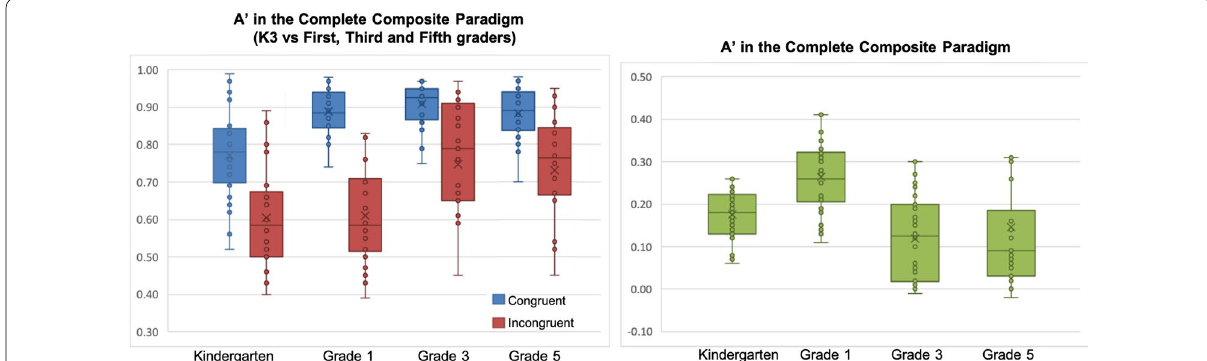
Fig. 4 A ′ of congruent and incongruent trials in the holistic processing task (left) and Holistic A ′ in Chinese first graders, third graders, fifth graders and kindergartners (right)